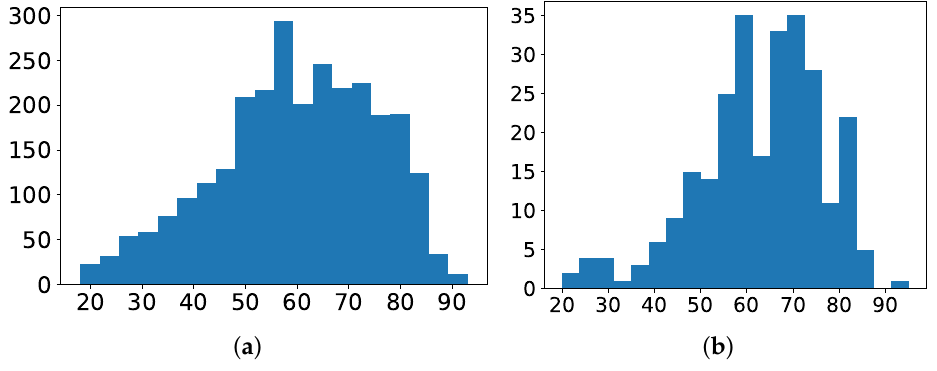
Figure 4. Histogram of age for: ( a ) non-MDR patients; and ( b ) MDR